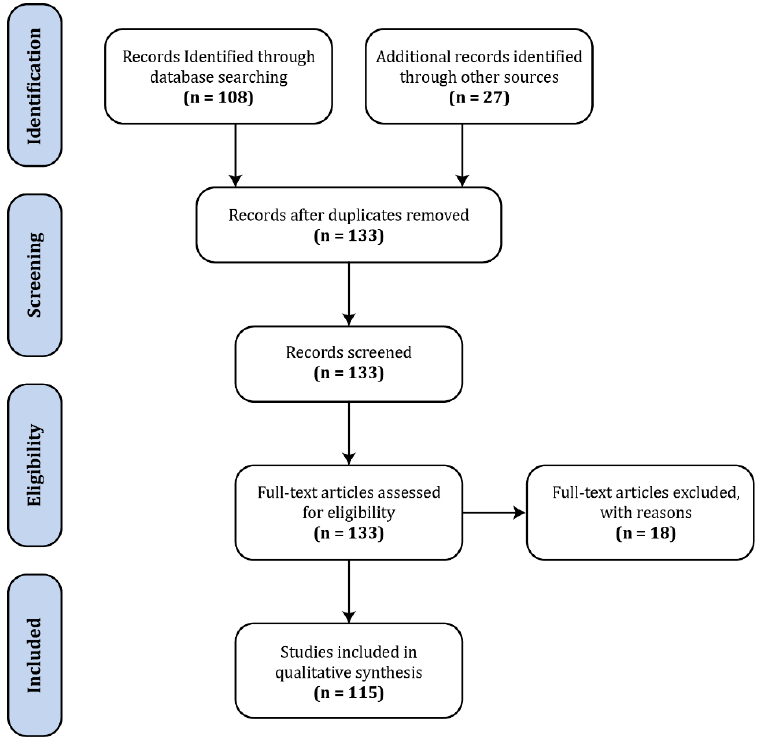
Figure 2. Flow chart of the literature review process.